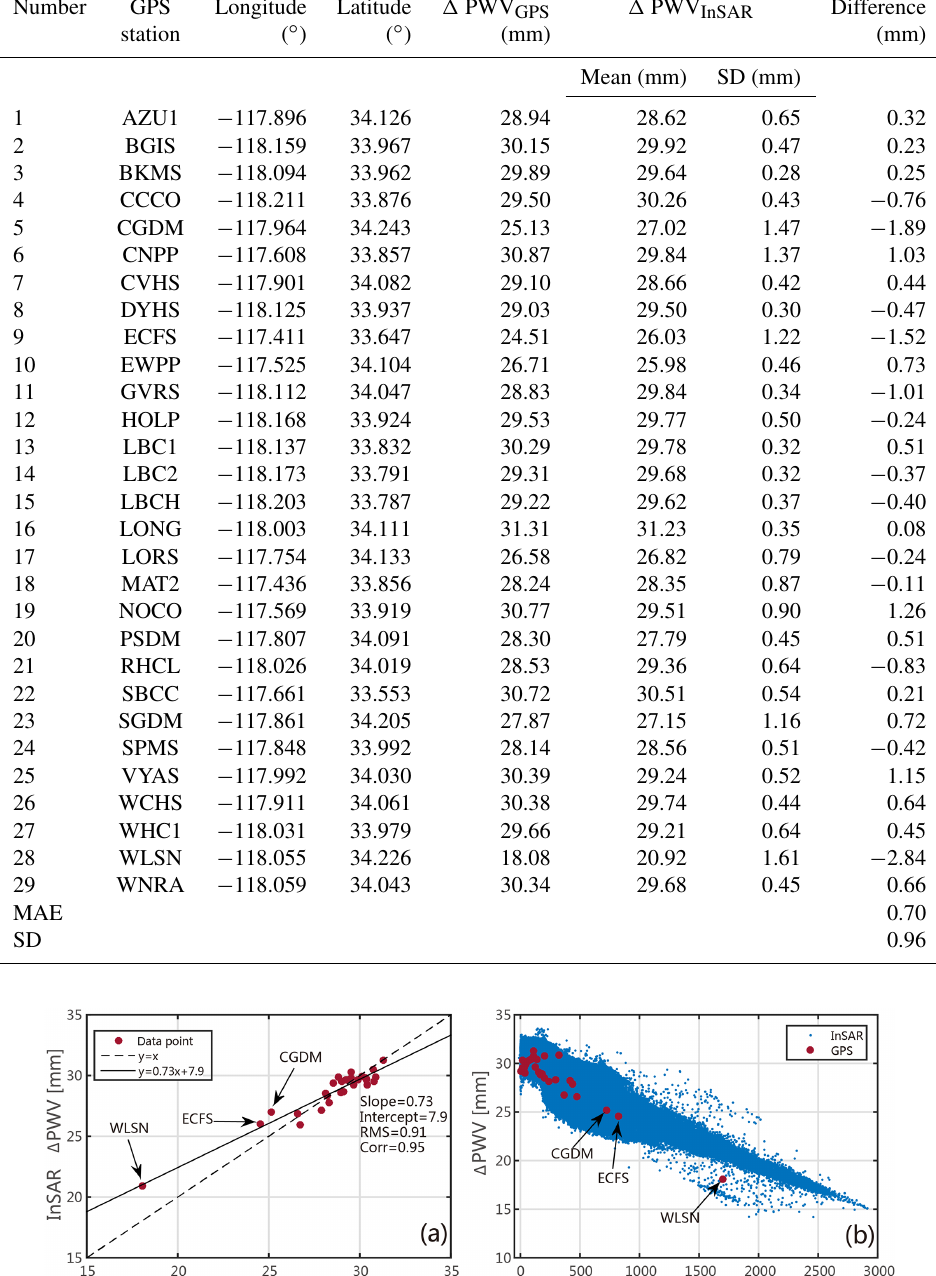
Table 3. Assessment of (cid:49) PWV maps obtained by InSAR after calibration of offset using GPS (master image from 16 August 2008, slave image from 25 October 2008). For each GPS station, PWV differences from GPS between master and slave SAR acquisition times are computed and compared to the average values of InSAR estimates at pixels located within a circular area of 5.4km around each GPS station. Differences are summarized in the last column. MAE and SD represent the mean absolute error and standard deviation.